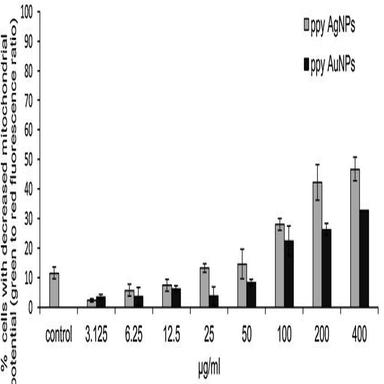
The cytotoxicity of PPy–Ag (white color) and PPy–Au (black color) powders against THP-1 cells measured as % cells with decreased mitochondrial potential.